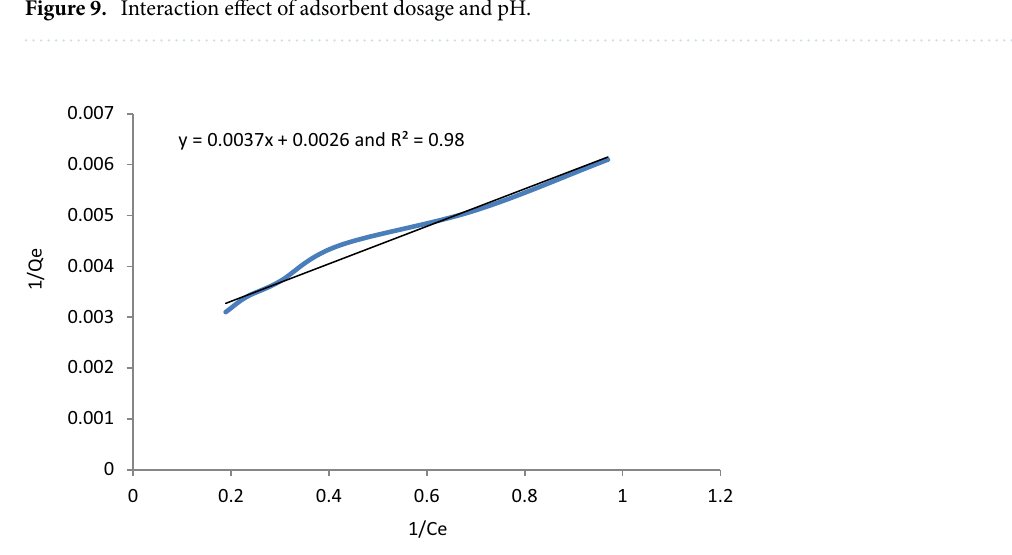
y = 0.0037x + 0.0026 and R² = 0.98